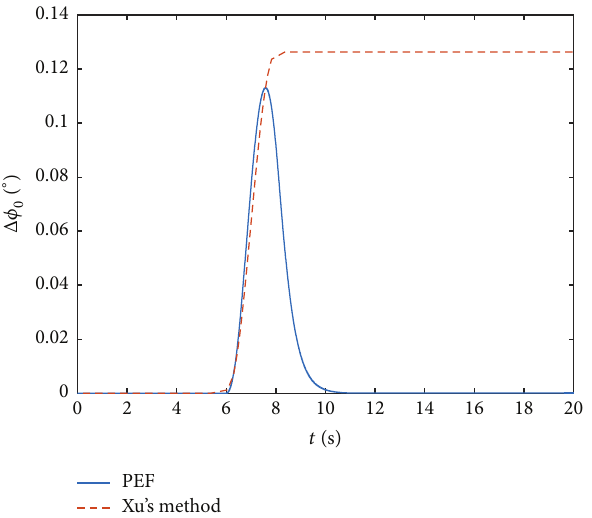
Figure 8: The variation of the base’s attitude